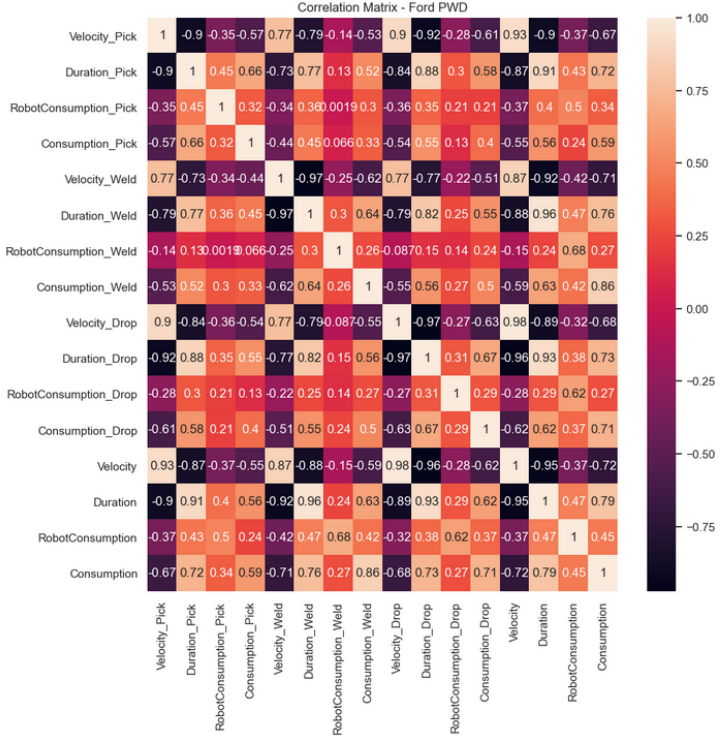
Figure 10. Correlation Matrix for the Ford_PWD model, showing the connection between the parameters Velocity, Duration, Robot Consumption and Consumption.